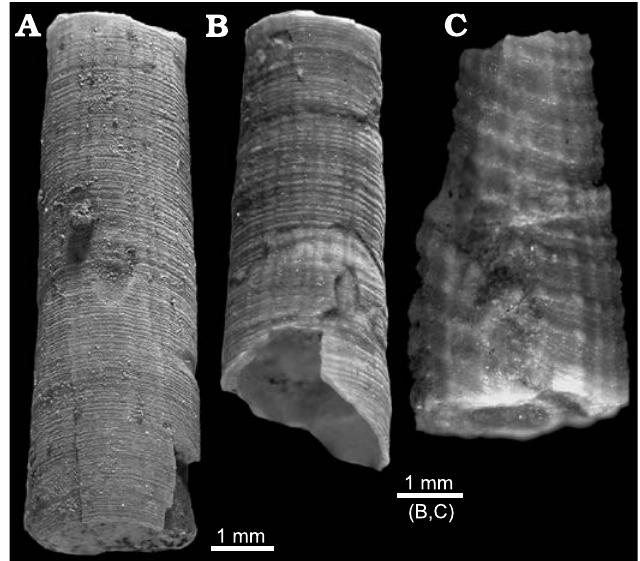
Fig. 29. Dentaliid scaphopods Dentalium klipsteini Kittl, 1891, from Lago Antorno, Cassian Formation, northern Italy, Late Triassic. PZO 12869 ( A ), PZO 12870 ( B ), and PZO 12871 ( C ), in lateral